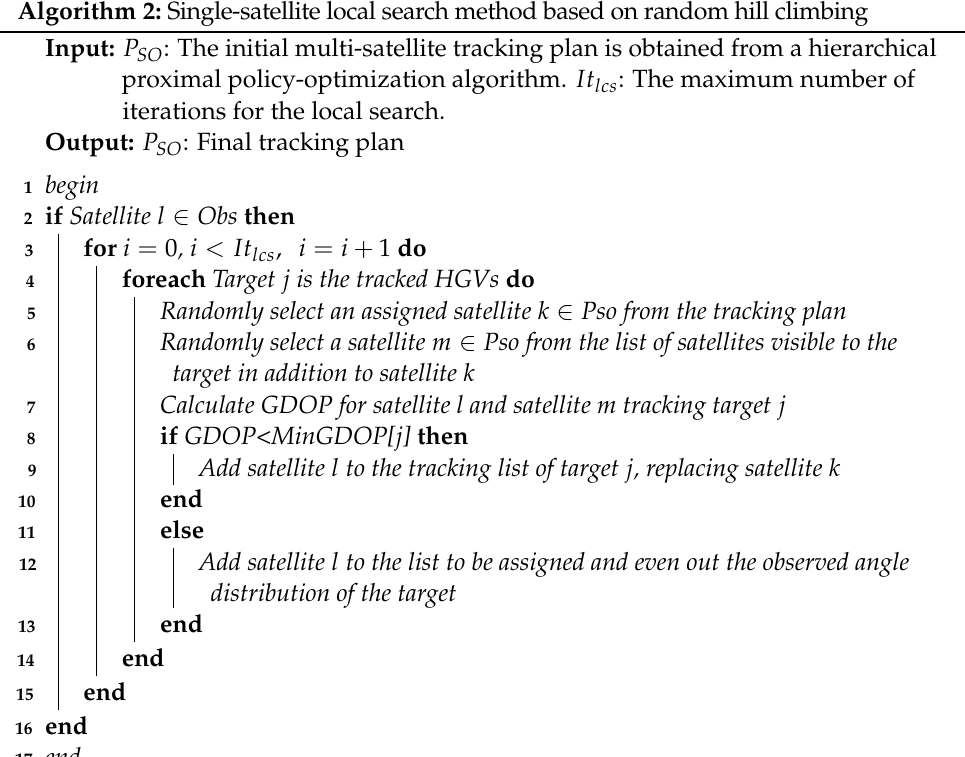
Algorithm 2: Single-satellite local search method based on random hill